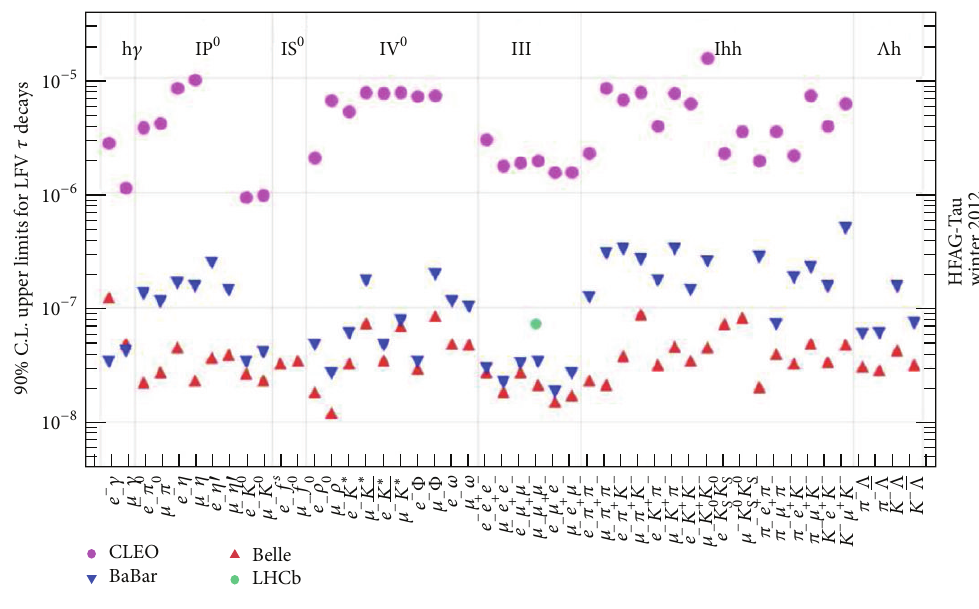
Figure 33: Summary of 90 % C.L. upper limits on CLFV tau decay branching ratios (adapted from [123]).